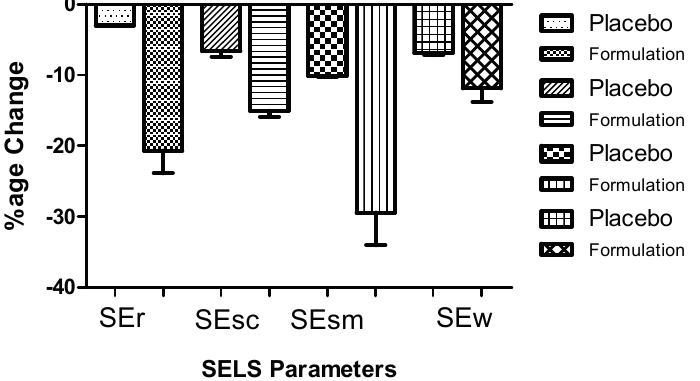
Figure 3. Percentage of global changes in mean Visioscan ® VC98 units of surface evaluation of living skin (SELS) parameters after application of formulation and placebo in respective cheeks of volunteers ( n = 13) during three months. Bars represent mean standard deviation (s.d.) of three independent experiments. Statistically significant ( p < 0.005) difference was observed between the effects of the active formulation and the placebo, for each of the four SELS parameters. SEr represents the index of skin roughness parameters; SEsc represents the index of skin scaliness/dryness; SEsm represents the index of skin smoothness; SEw represents the index of skin